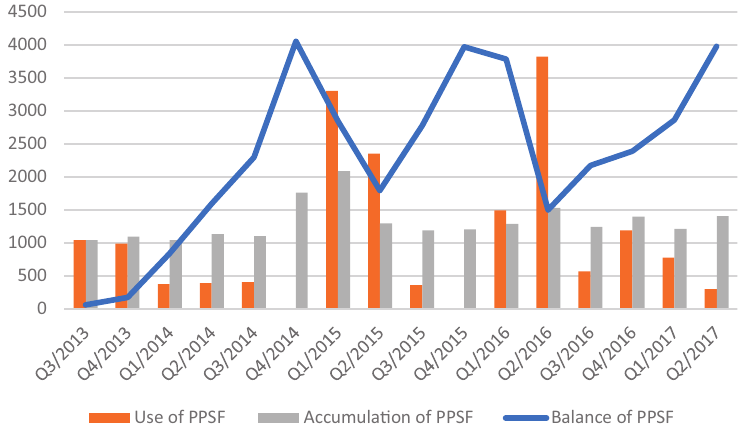
Figure 3. Petroleum